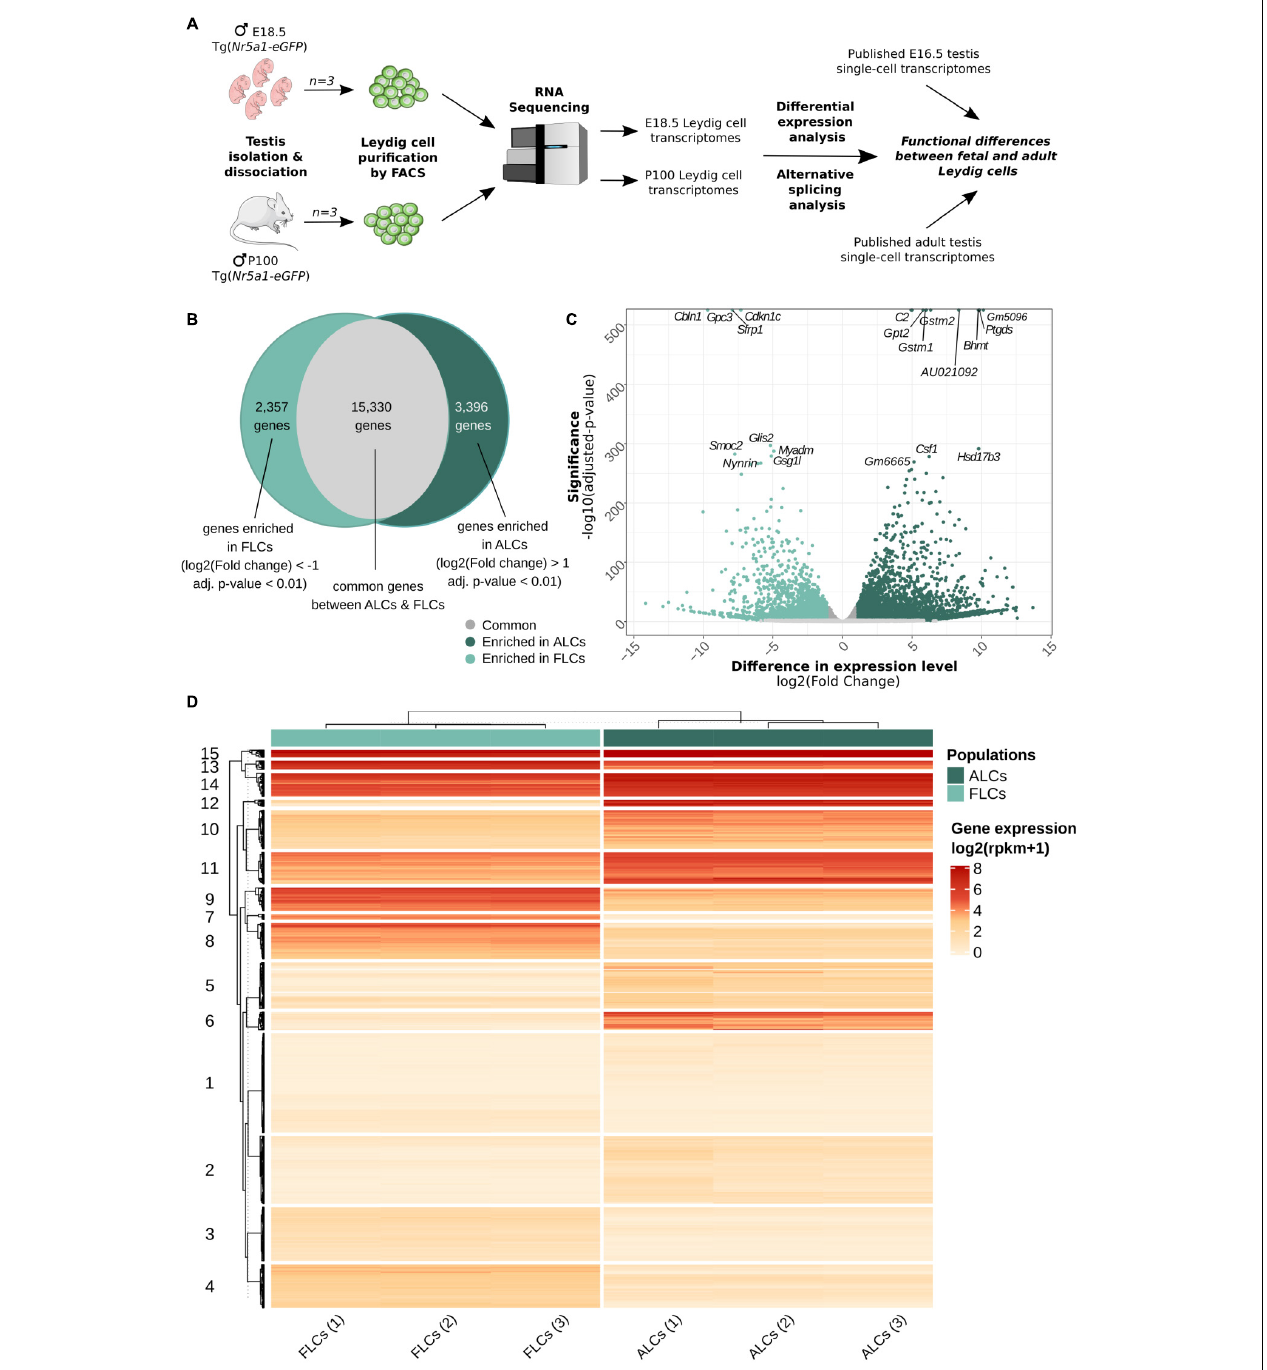
FIGURE 1 | Similarities and differences between FLCs and ALCs. (A) Sample collection, RNA-sequencing and analysis workflow. (B) Venn diagram showing the number of genes expressed at same levels in FLCs and ALCs (12,645 genes), enriched in FLCs (3,741 genes) and enriched in ALCs (4,657 genes). (C) Volcano plot displaying differential expressed genes between FLCs and ALCs. The x -axis corresponds to the log2(Fold Change) and the y -axis corresponds to the –log10(adjusted p -value). The salmon dots represent the significant up-regulated transcripts in FLCs (adj. pval < 0.01); the blue dots represent the significant up-regulated transcripts in ALCs (adj. pval < 0.01) and the gray dots represent the not significantly differentially expressed transcripts (adj. pval > 0.01). Top 30 genes according to the adjusted p -value are displaying on this volcano plot. (D) Heatmap displaying the normalized scaled expression of differentially expressed genes in the 6 samples. Genes are ordered with hierarchical clustering according to their expression pattern into 15 groups.